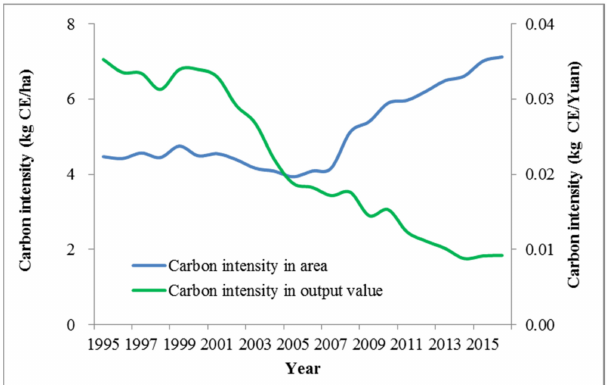
Figure 6. Change in carbon intensity in Qinghai province over 1995–2016.